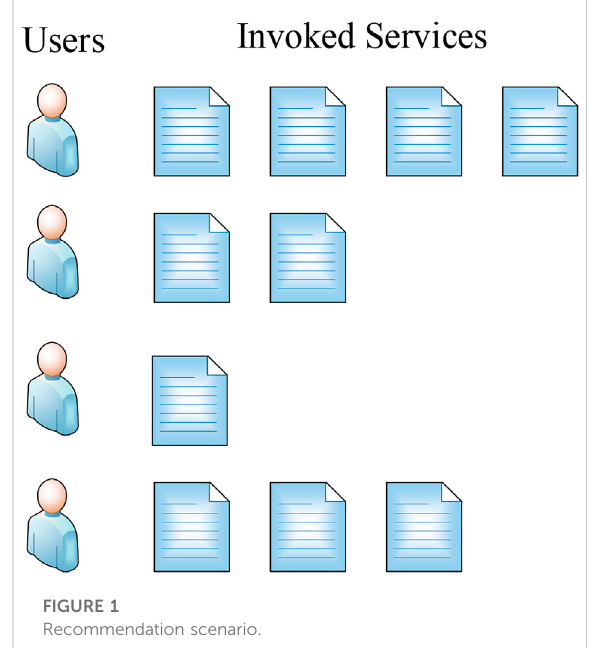
FIGURE 1 Recommendation